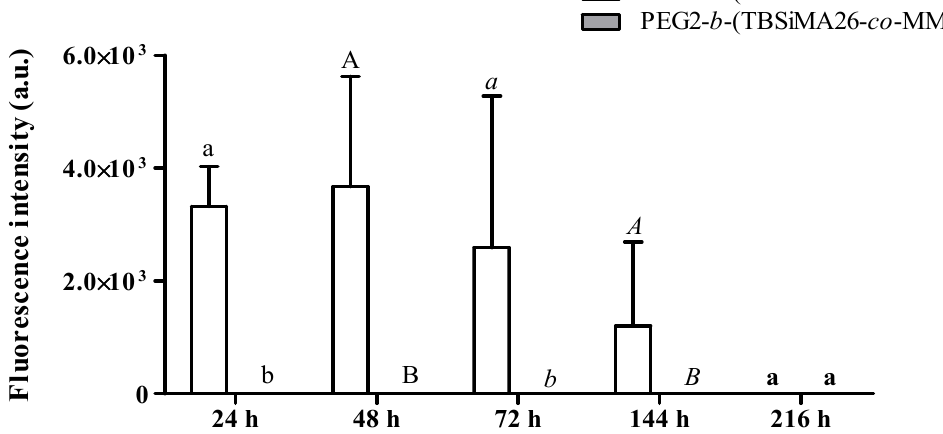
Figure 8. Intensity of fluorescence emitted by Navicula salinicola cells adherent to different surface samples after 24 h (lowercase letters), 48 h (uppercase letters), 72 h (italics lowercase letters), 144 h (italics uppercase letters), and 216 h (bold lowercase letters) of exposure. A PERMANOVA analysis (n = 4) was performed on sample results for each exposure time. Not-shared letters indicate statistically significant differences, p ≤ 0.05.